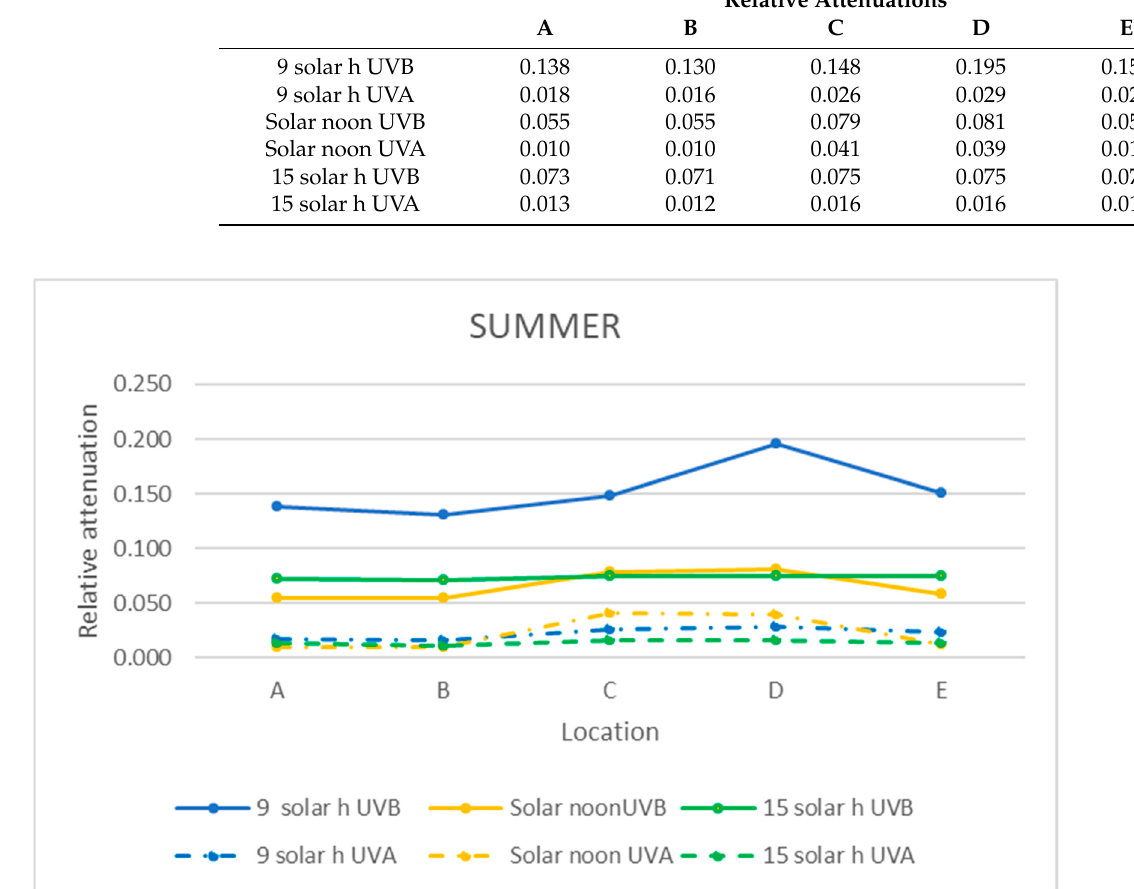
Figure 11. Representation of the mean relative attenuation for the UVB and UVA ranges for the 5 locations studied in summer at three times of day. Table 3. Values of mean relative attenuations for the UVB and UVA bands in summer at three times of day.